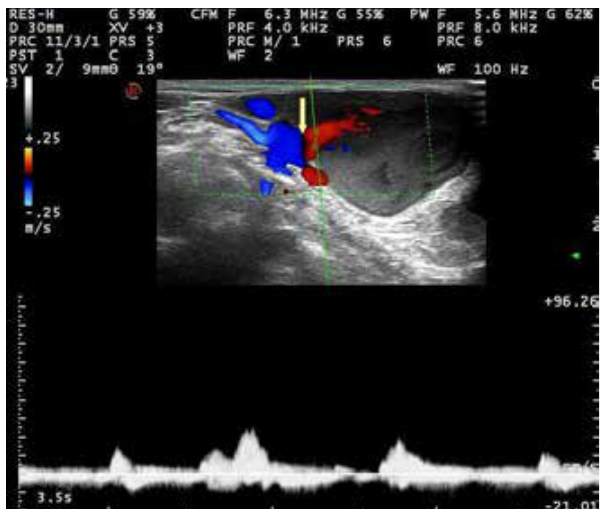
Figure 2 Longitudinal colour Doppler ultrasonography of the mass. Pulsed Doppler profiled the sample volume in the “rupture” (arrow), showing bidirectional and low velocity